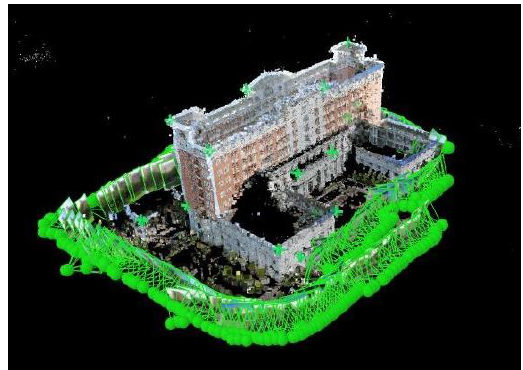
Figure 7. Point cloud of the building generated by Pix4dmapper.